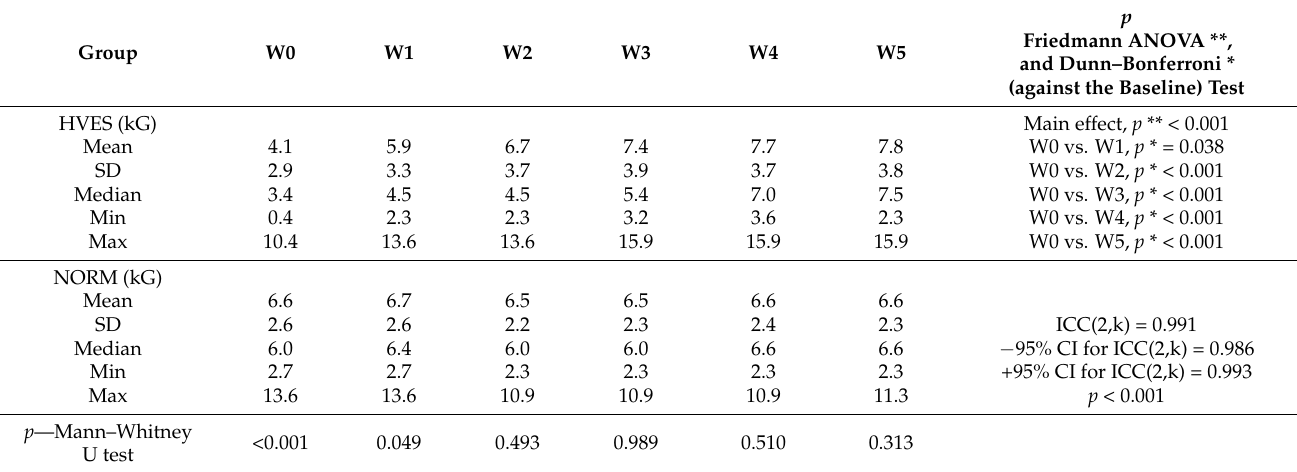
Table 4. The dynamometric measurement of wrist extensor strength. ICC, interclass correlation coefficient model (for six trials of the wrist extensors strength). Abbreviations: W0, baseline (before treatment); W1, after treatment; W2, 3 weeks after treatment; W3, 6 weeks after treatment; W4, 12 weeks after treatment; W5, 24 weeks after